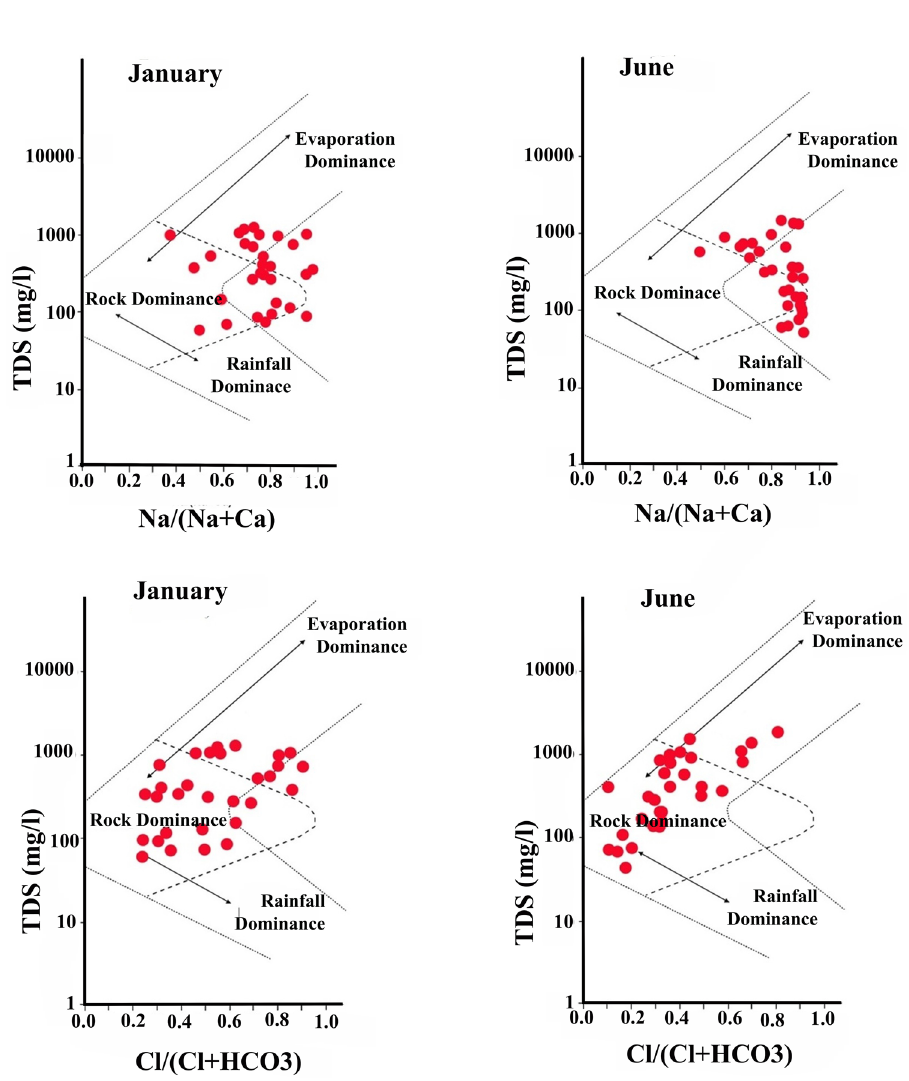
Fig. 10 Gibbs plot showing mechanisms controlling the groundwater chemistry of the study